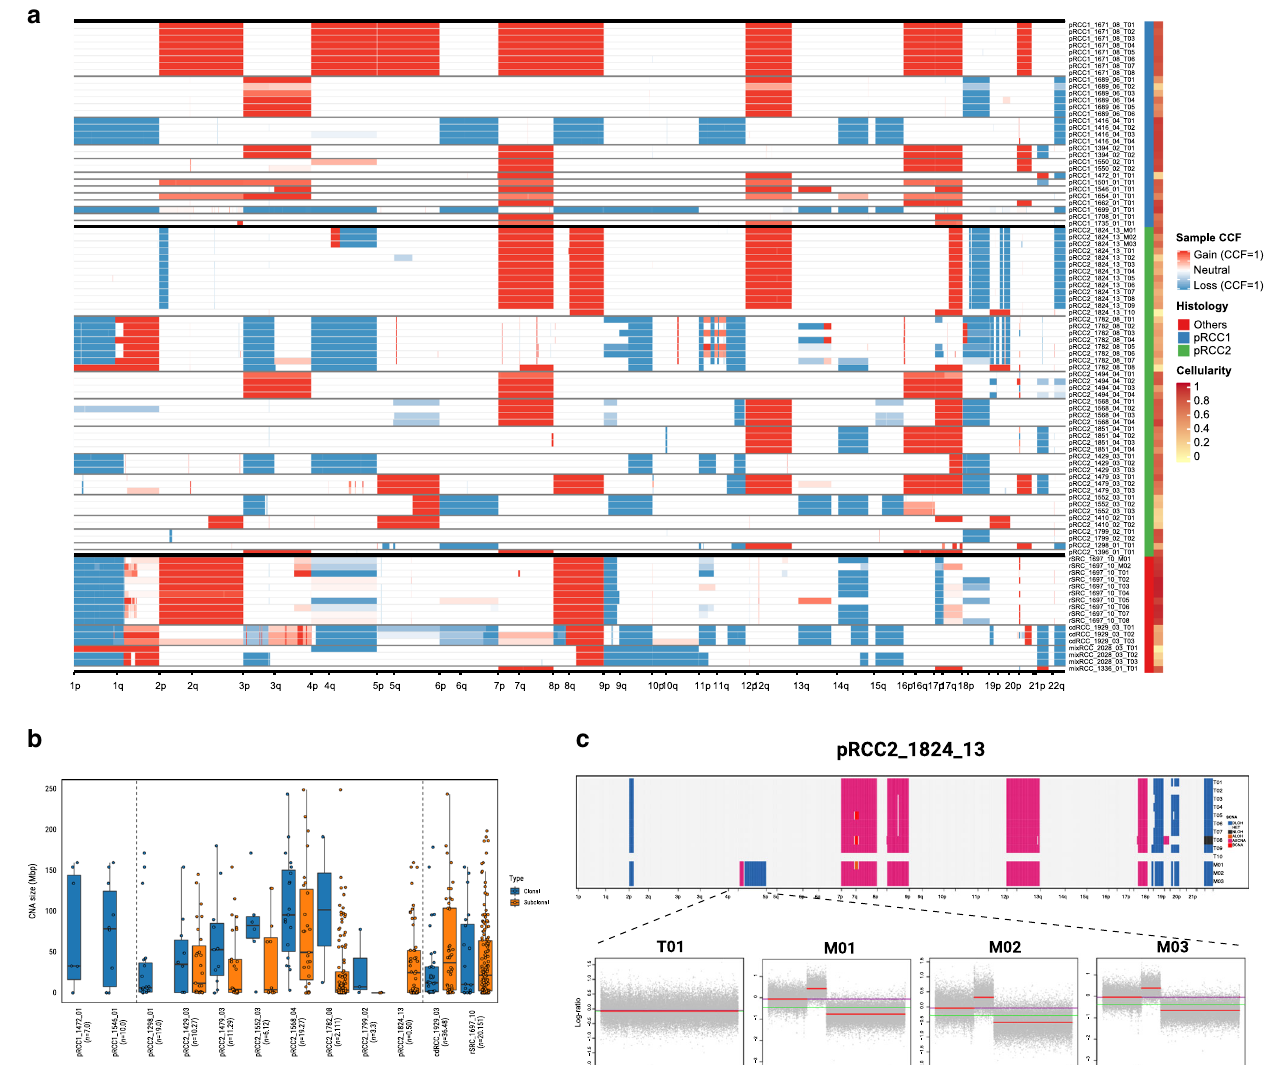
Fig. 3 Somatic copy number alterations (SCNAs). a Genome-wide sample cancer cell fraction (CCF) pro fi les across tumors. Samples are labeled by histology subgroup and cellularity (or called purity). ( b ) Size of SCNAs identi fi ed in each tumor, separated into clonal alterations (purple), which have a shared breakpoint across all samples from a tumor and subclonal alterations (yellow), which have breakpoints that are found only in a subset of samples from a tumor. Where clonal and subclonal SCNAs are both identi fi ed in a tumor, they are shown side by side. The numbers of clonal and subclonal SCNAs are included in the parentheses following the tumor ID, such as pRCC1_1472_01(n = 7,0). Vertical lines separate pRCC1 (left), pRCC2 (middle) and rare subtypes (right). In each box-and-whisker plot, the line dividing the box represents the median; the ends of the box are the lower (Q1) and upper